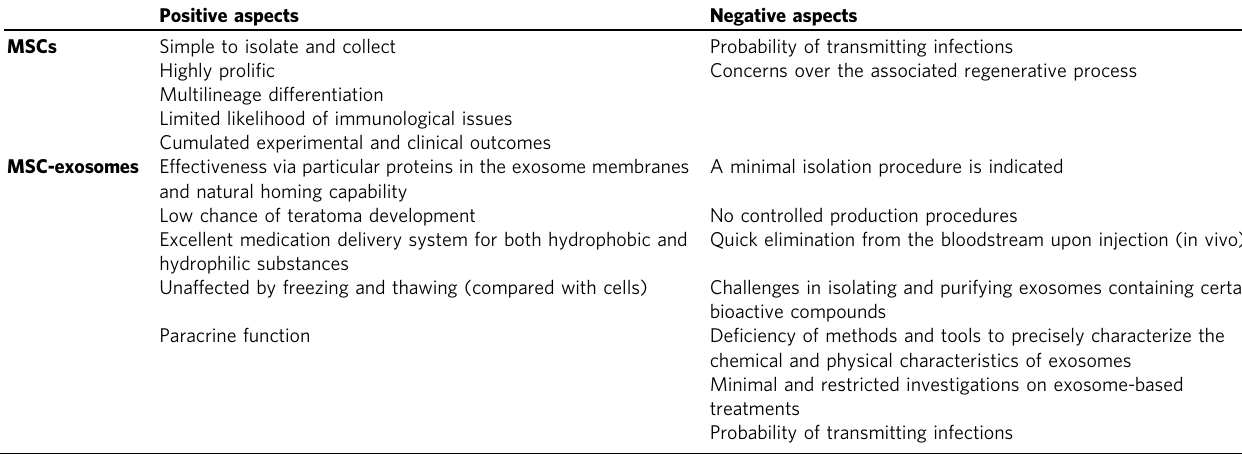
Table 1 MSCs and MSC-exosomes for therapeutic applications: bene fi ts and